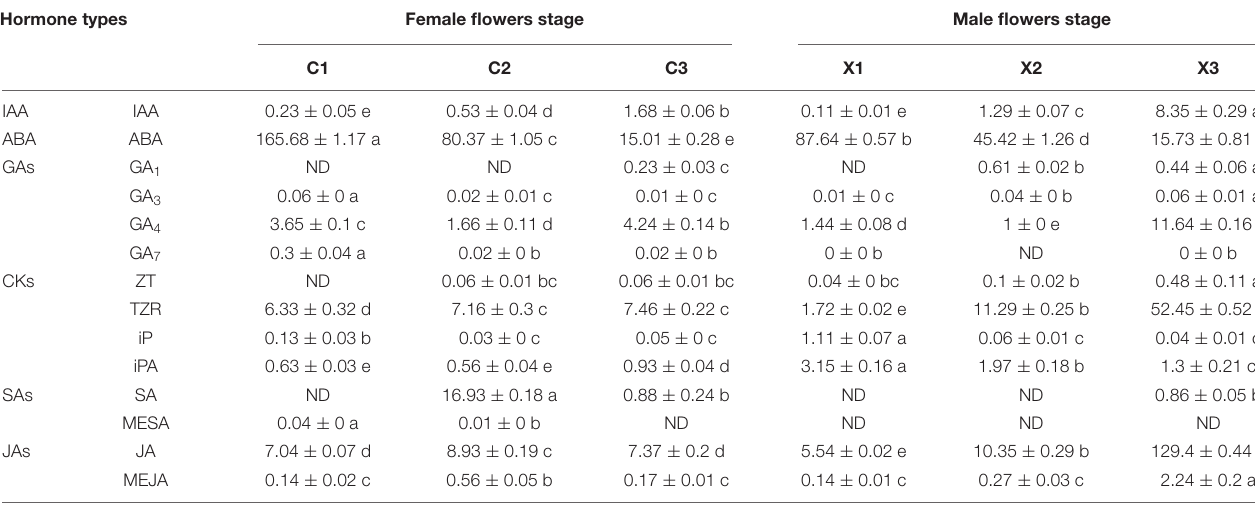
TABLE 1 | Levels of phytohormones in male and female flowers of tung tree. Hormone types Female flowers